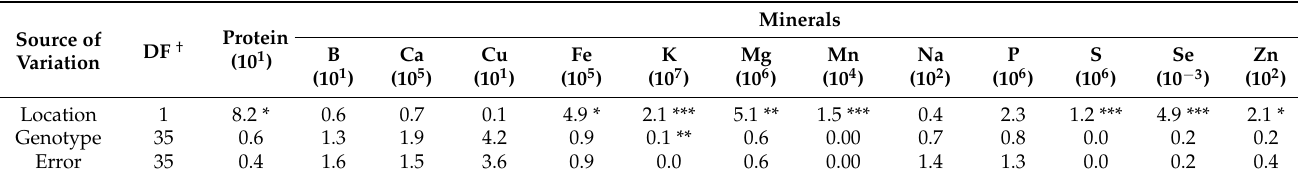
Table 3. Mean squares from the analyses of variance (ANOVA) of the seed protein concentration and content of minerals in noug.